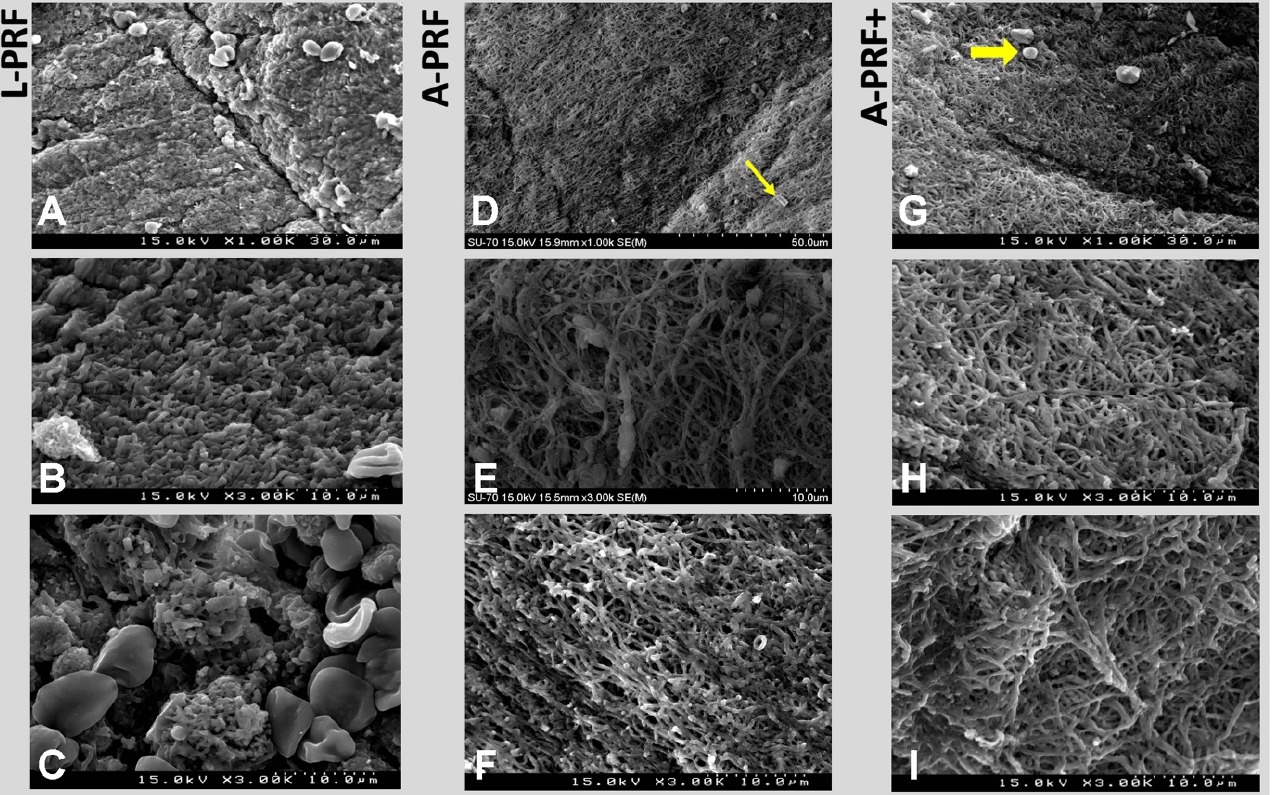
Figure 5. SEM images. ( A – C ) L-PRF: Matrix with a highly compact surface with thick fibers present within interfibrous areas as well as limited and reduced space for microvascularization ( A , B ). Destruction of red blood cells and leukocytes is visible ( C ). ( D – F ) A-PRF shows a dense matrix ( D ) composed of thin and elongated fibers that follow a preferential and orientated direction ( E , F ) in which the platelets are well-adhered. Porosity is also evident with a large diameter of the interfibrous spaces ( E ). Silica microparticles lying on the surface (( D ), yellow arrow). ( G – I ) A-PRF+: The amount of fibers cross-linking is even more noticeable than the porosity as the presence of intact lymphocytes are adhered to the surface of the mesh ( G ).